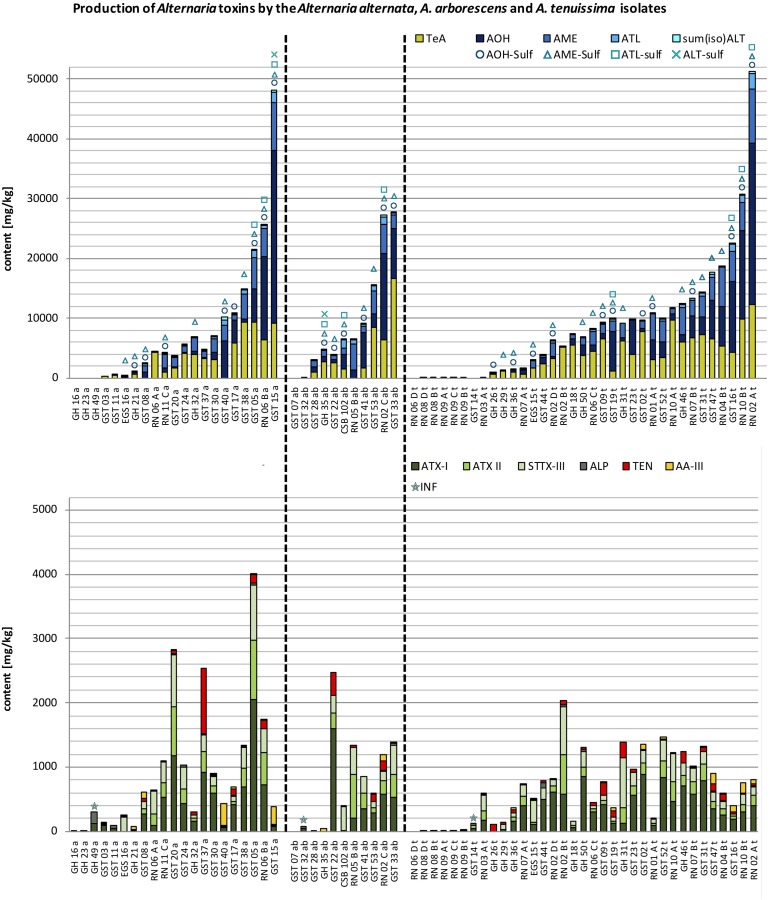
Stacked column charts – in ascending order regarding the total toxin production – of the quantitative production of tenuazonic acid (TeA), alternariol (AOH), alternariol mono methylether (AME), altenuisol (ATL) and the sum of altenuene and isoaltenuene [sum(iso)ALT] in comparison to the quantitative production of altertoxin I (ATX-I), altertoxin II (ATX-II), stemphyltoxin III (STTX-III), alterperylenol (ALP), tentoxin (TEN), and altenuic acid III (AA-III) after 14 days at 25°C in rice in mg/kg by the A. alternata (a), A. arborescens (ab), and A. tenuissima (t) species-group isolates (please note different scaling due to differences in concentration). The detection of alternariol sulfate (AOH-sulf), alternariol mono methylether sulfate (AME-sulf), altenuisol sulfate (ATL-sulf), altenuene sulfate (ALT-sulf) or infectopyrone (INF) is marked with the respective symbol.